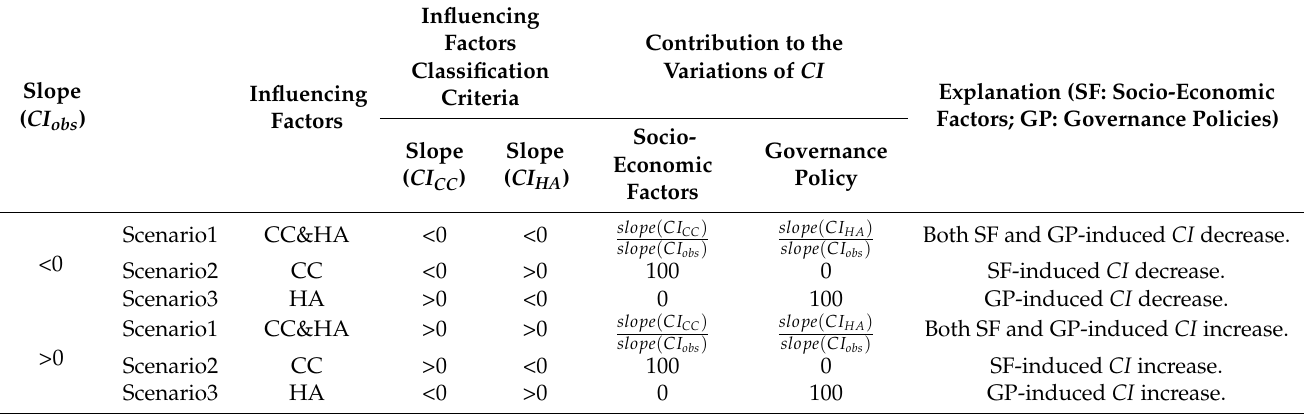
Table 2. Methods for assessing the relative